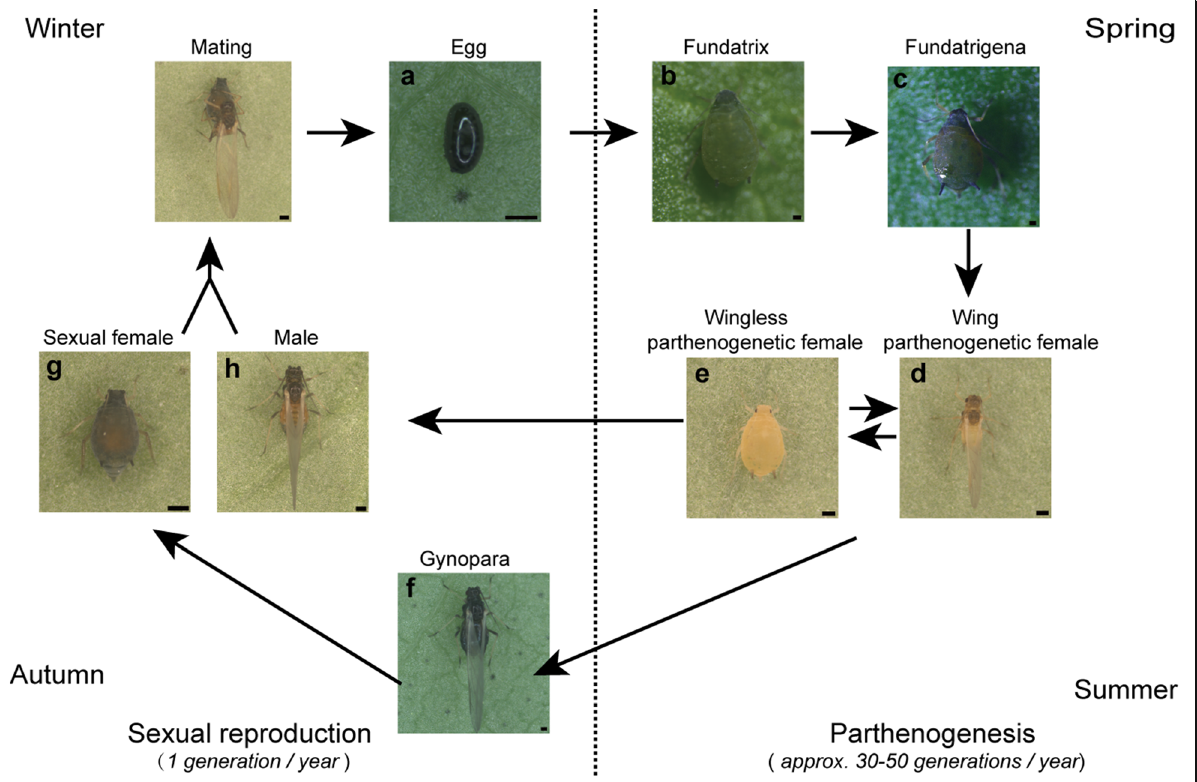
Fig. 1 Annual life cycle of cotton aphid. Cotton aphid has three representative winged morphs in its life cycle. In spring, the overwintering egg ( a ) hatches and develops into the fundatrix ( b ), which gives birth to fundatrigena ( c ) on primary host plants. The fundatrigena undergoes several generations and then produces wing parthenogenetic female ( d ), which migrates to second hosts, such as cotton, in late spring. During summer, cotton aphid alternatively chooses morphs between wing or wingless parthenogenetic females ( e ) over a dozen of generations to adapt to changing conditions, such as population density or host plant quality. In autumn, exclusively winged GP ( f ) and male ( g ) are produced successively and migrate to the primary hosts. Sexual female ( h ) is produced by GP and oviposits overwintering fertilized eggs after mating with the male ( i ). All these morphs above were captured in wild field. Scale bars, 0.2